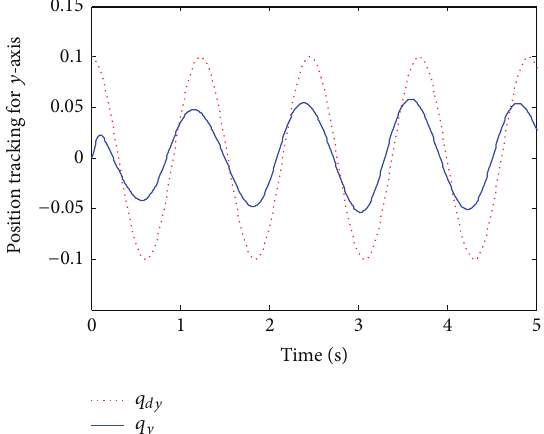
Figure 9: RBF network approximation of 𝑦 -axis component with adaptive neural sliding compensator.